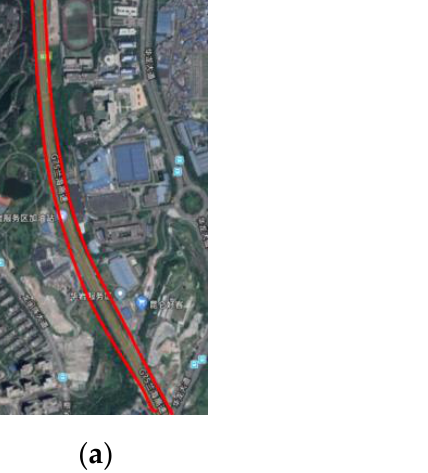
Figure 12. The test road: ( a ) The test road high-precision map; ( b ) The test road virtual scene.